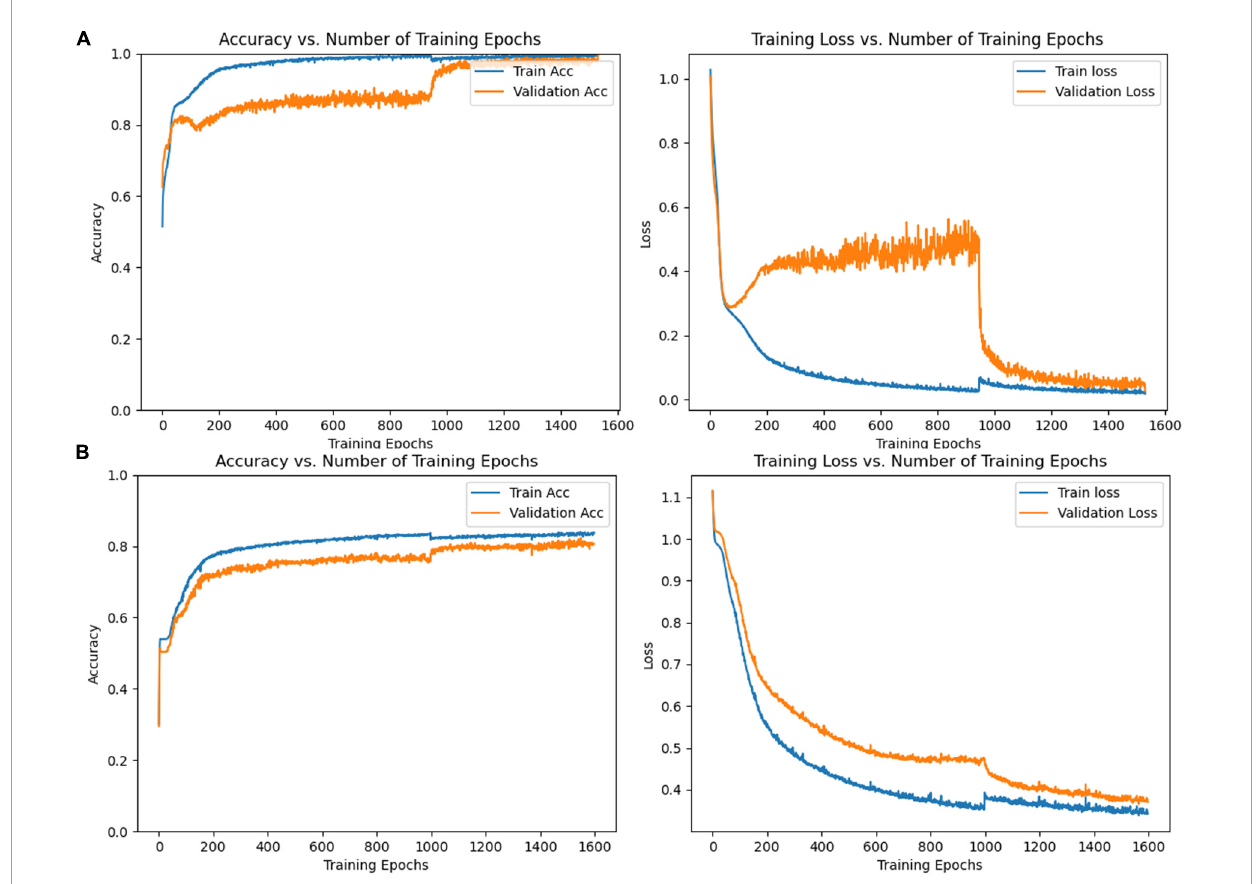
FIGURE8 (A) Accuracy and loss rate change curve of training set and validation set trained with EEG, (B) accuracy and loss rate change curve of the training set and validation set trained with PLI